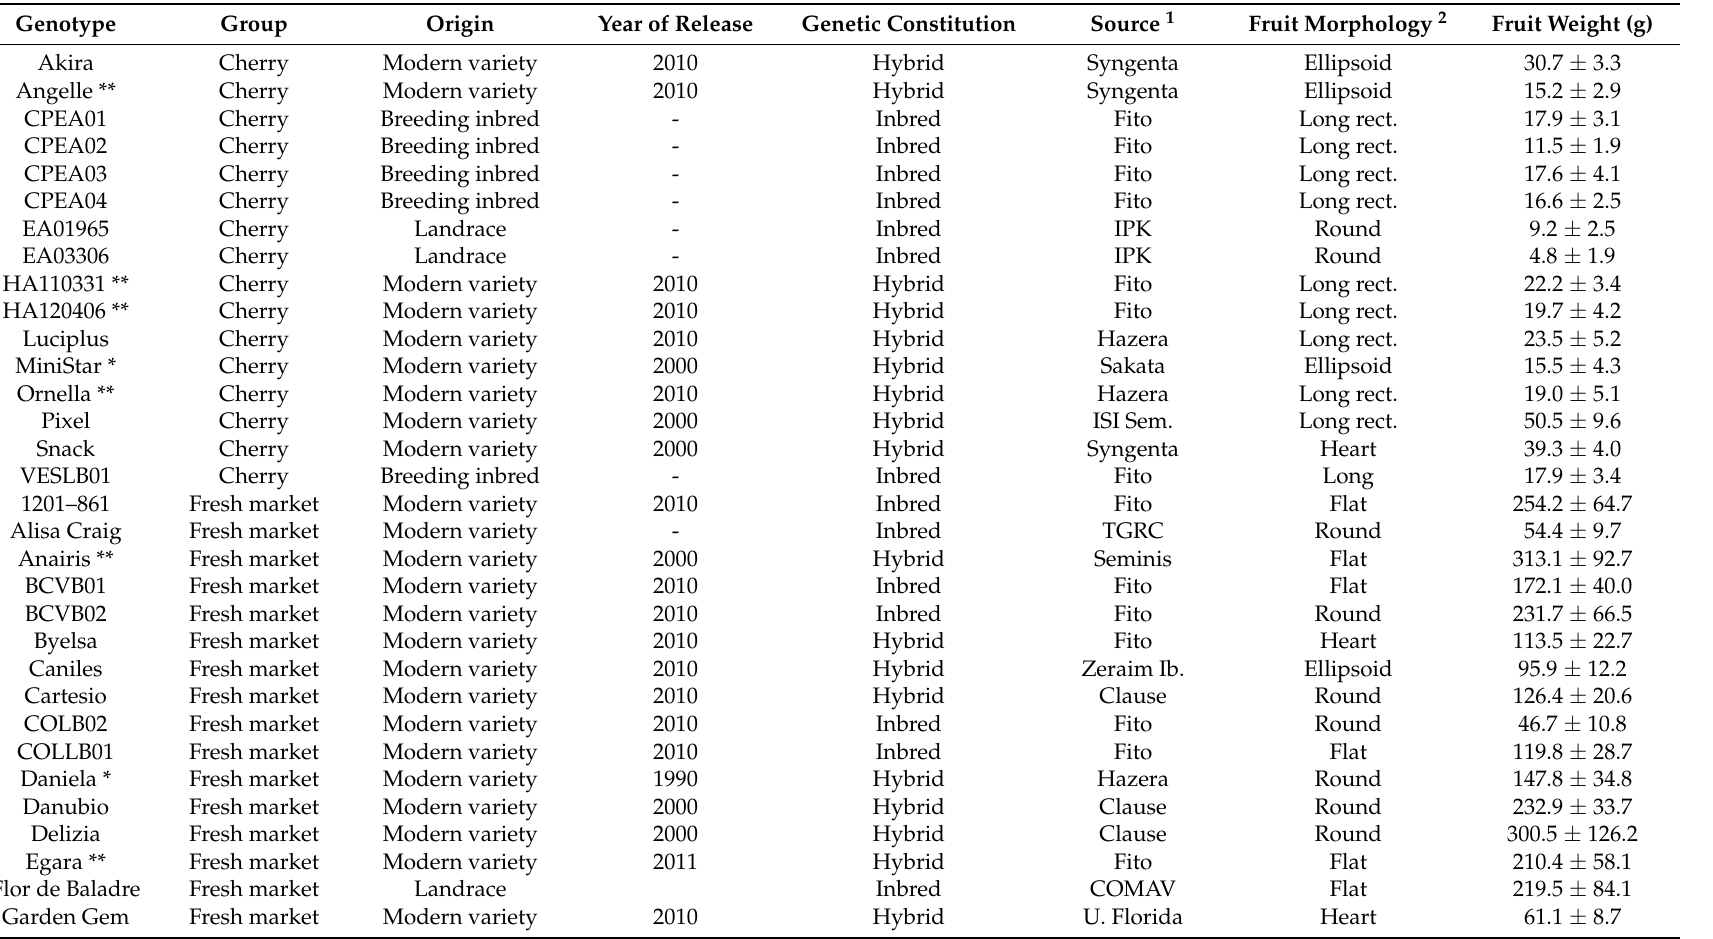
Table 1. Main characteristics of the germplasm assayed. Accessions in which sensory traits were evaluated are marked with asterisks: * marks those evaluated only by the trained panel and ** marks those evaluated by both the trained panel and untrained